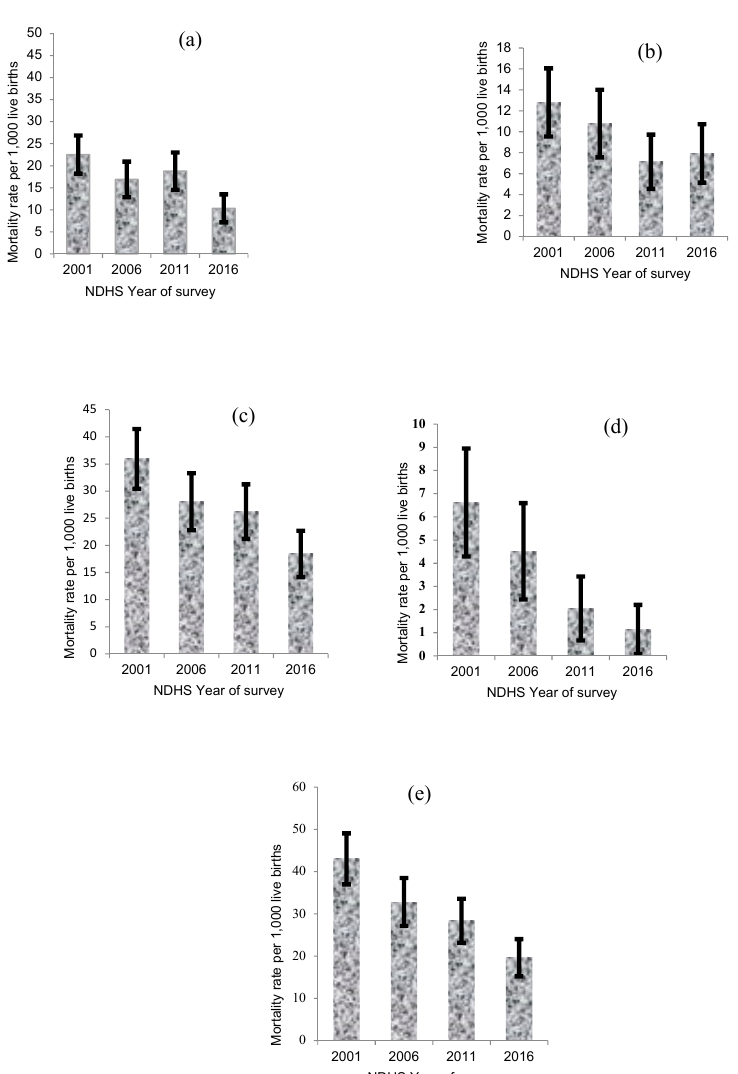
Figure 1. ( a ) Neonatal, ( b ) post-neonatal, ( c ) infant, ( d ) child and ( e ) under-five mortality per 1000 live births with 95% CI by year of survey, Nepal .